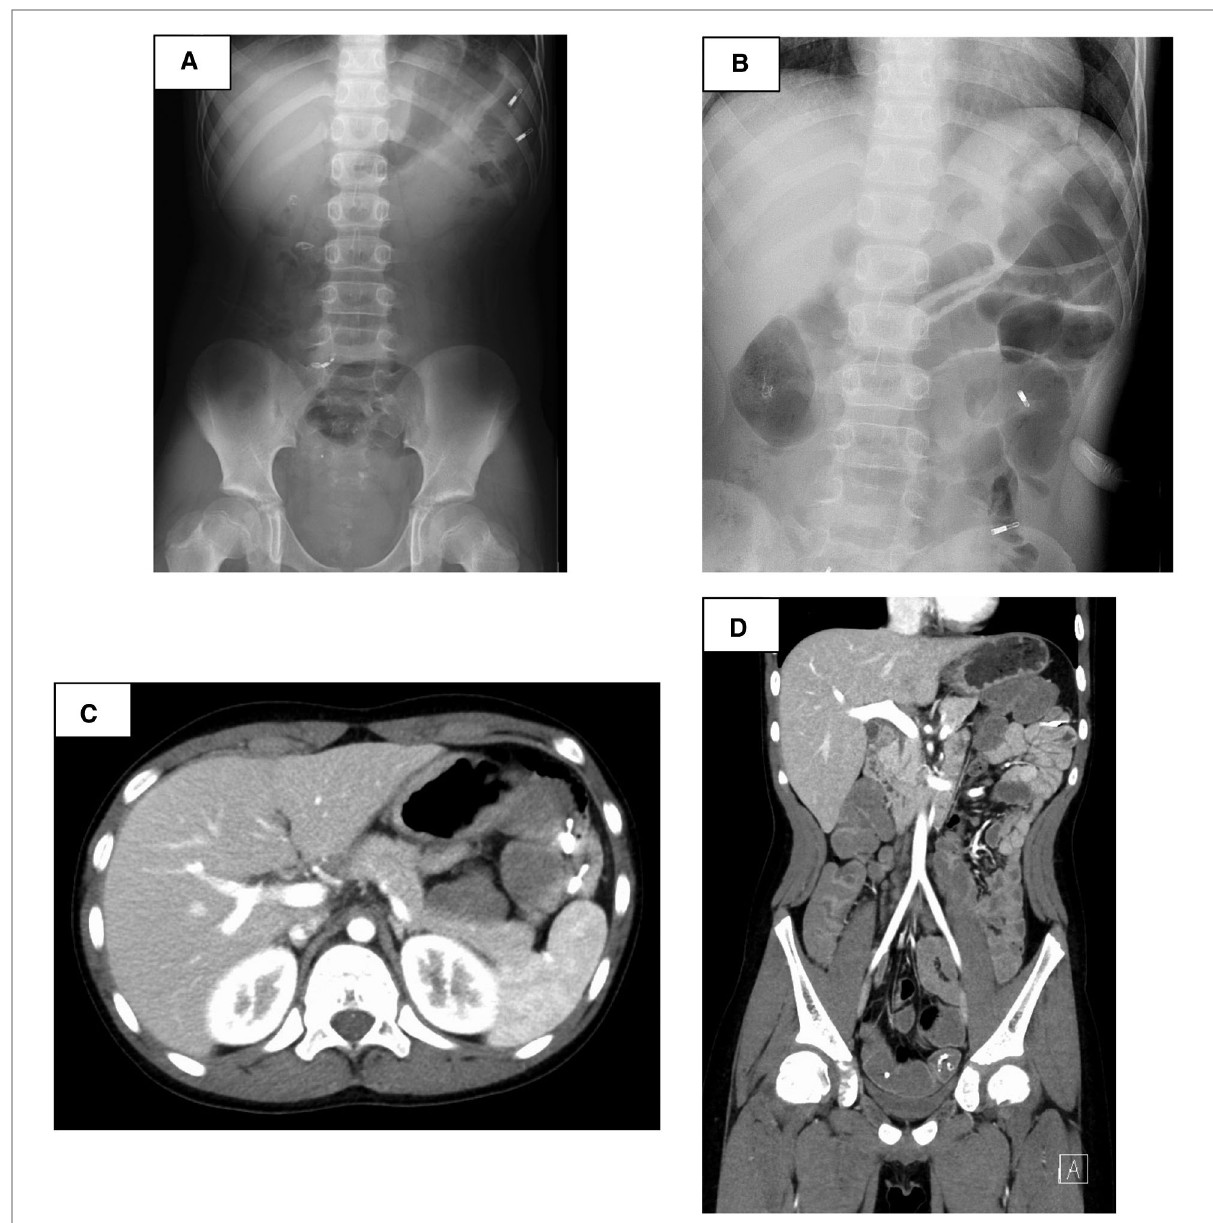
FIGURE 4 After endoscopic mucosal resection — suspected post-bleeding, abdominal x-rays ( A ) and enhanced abdominal computed tomography scan revealed that the position of the clips had not changed from the position immediately after EMR ( B ), and there were no signs of gastrointestinal perforation or arterial bleeding ( C,D